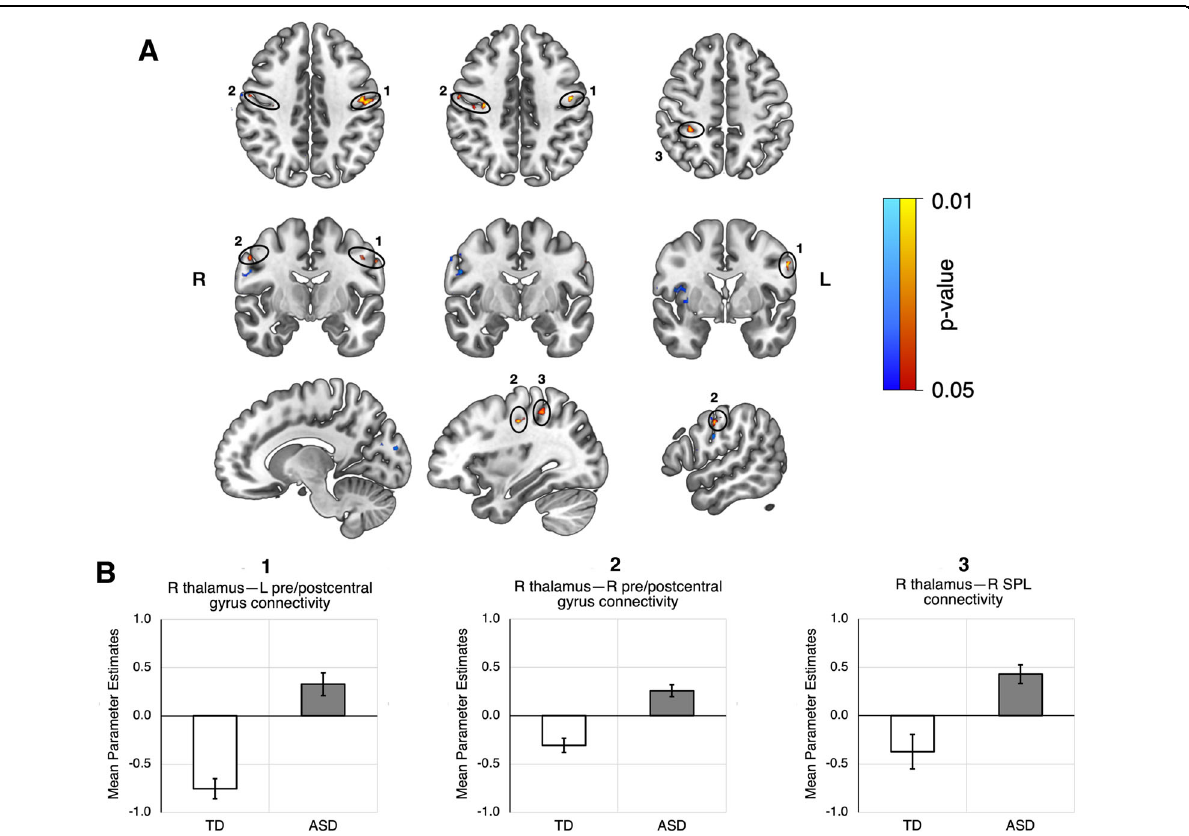
Fig. 1 Voxels that were found to exhibit hyperconnectivity with the right thalamus. Signi fi cant clusters found in the HFASD (orange) and ABIDE (blue) cohorts are colored by p-value. A Top - axial view, middle - coronal view, bottom - sagittal view, sliced from center to right. HFASD clusters are primarily localized in the left and right precentral gyri, left and right postcentral gyri, and right superior parietal lobule. ABIDE clusters are primarily localized in the right precentral and postcentral gyri, right insulae, and right and left cuneus. B Bar graphs depicting group differences in group-level GLM parameter estimates, taken as an average of all the voxels in a particular cluster for each subject. The two clusters in the right precentral and postcentral gyri (Table 3) were averaged together as one cluster. SPL = superior parietal